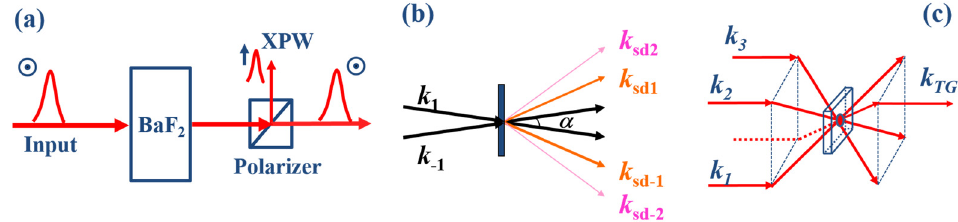
Figure 3. Principles of ( a ) cross-polarized wave generation (XPW), where a polarizer is used to separate the generated XPW. ( b ) Self-diffraction (SD) process, where k sd1 and k sd2 are the first- and second-order SD signals, respectively. ( c ) Transient-grating (TG) process, where K TG is the generated TG signal. Two focal lenses, one before and one after the medium, were omitted for simplification.